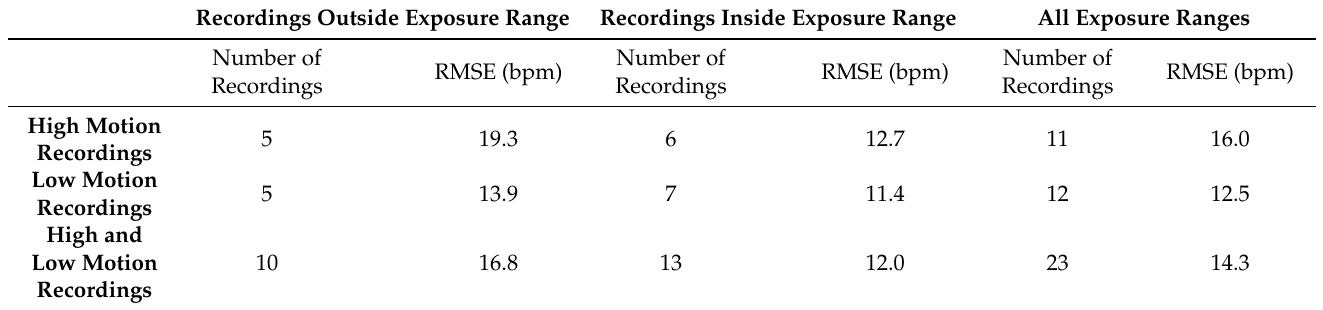
Table 3. RMSE bpm for the different subsets according to the recording